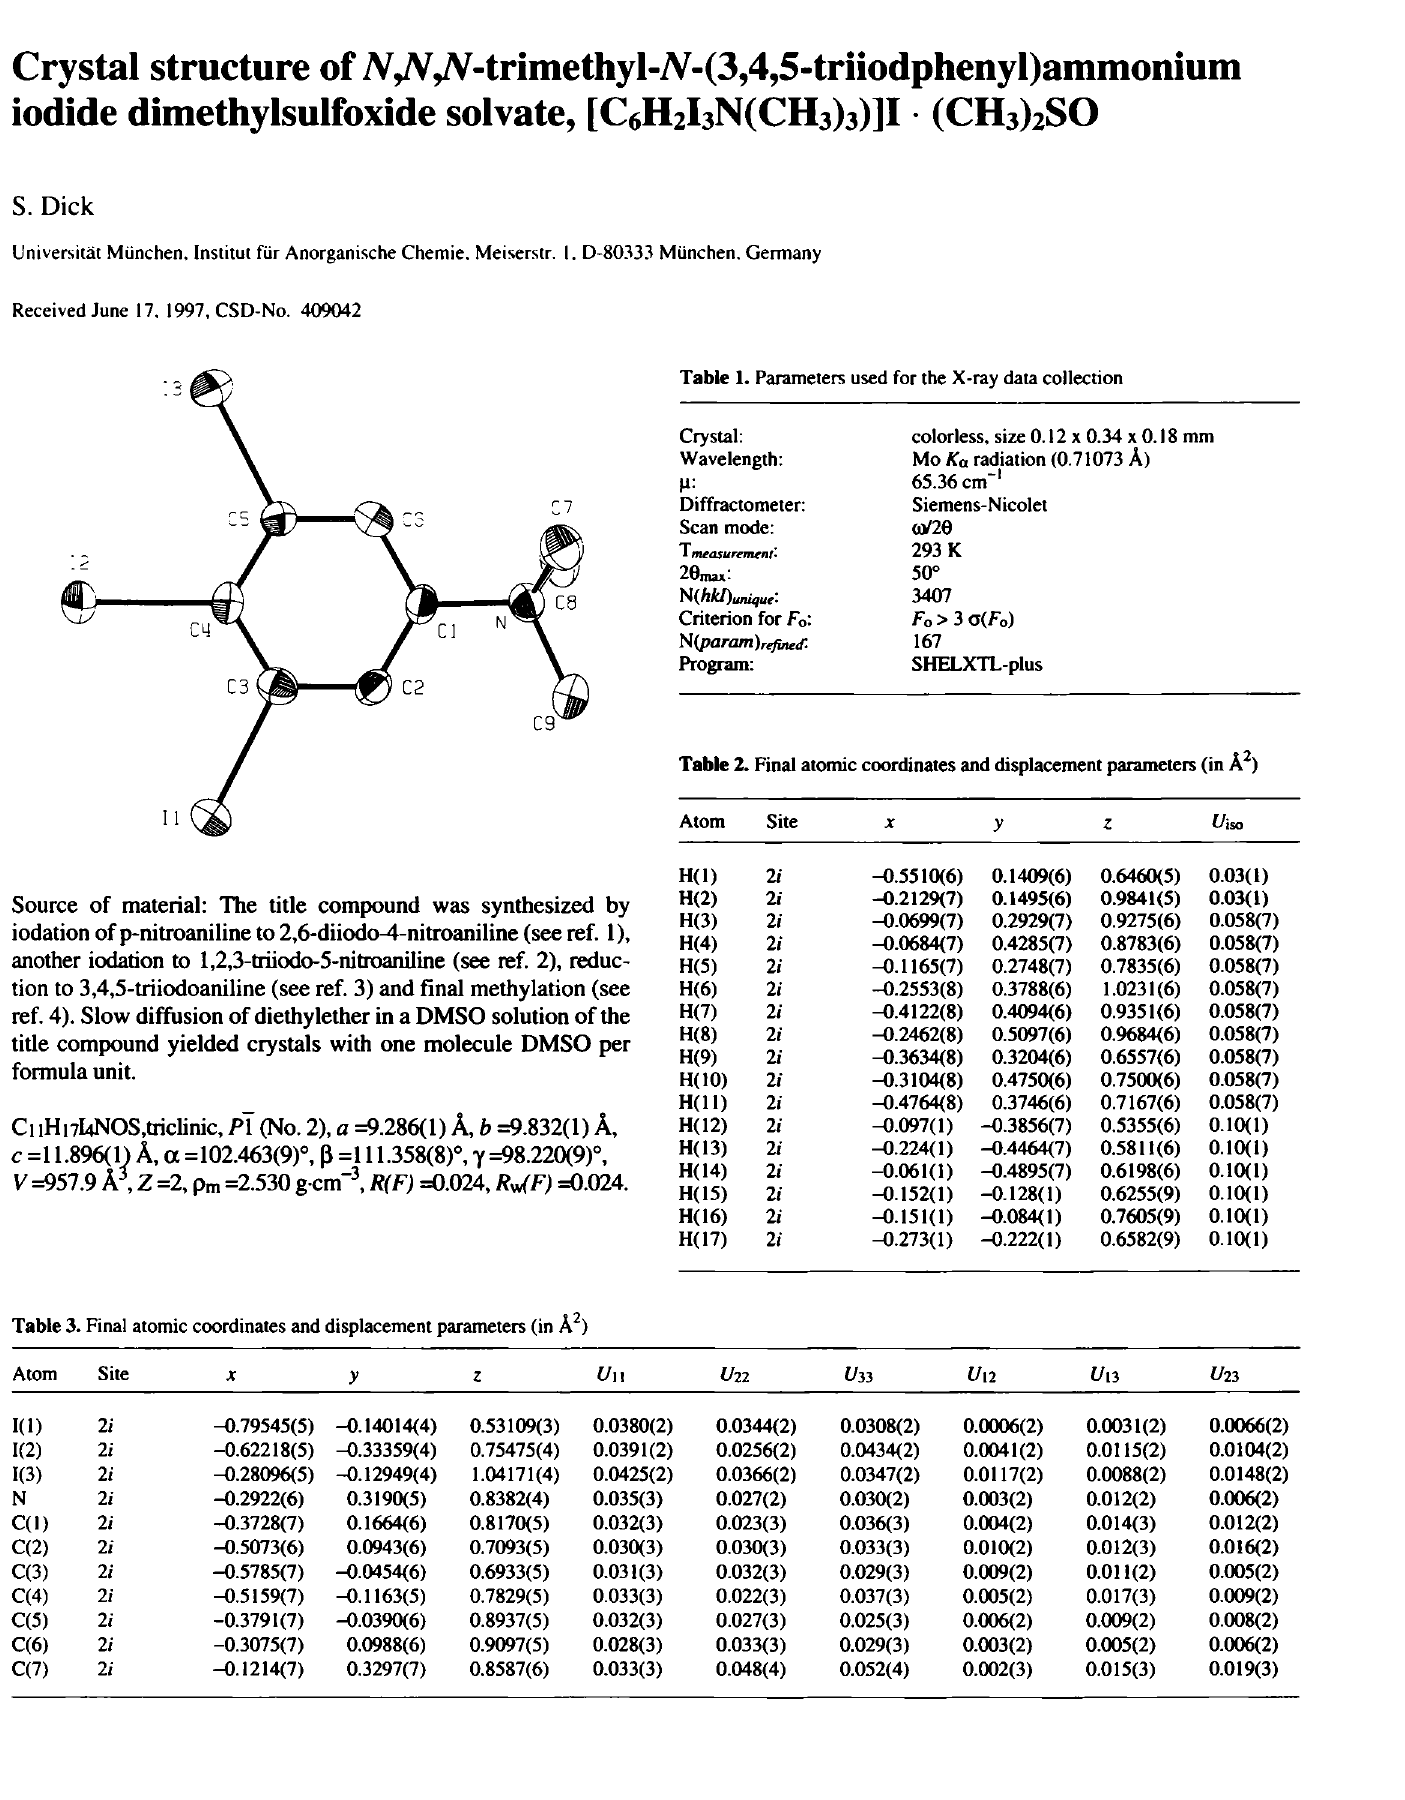
Table 1. Parameters used for the X-ray data collection